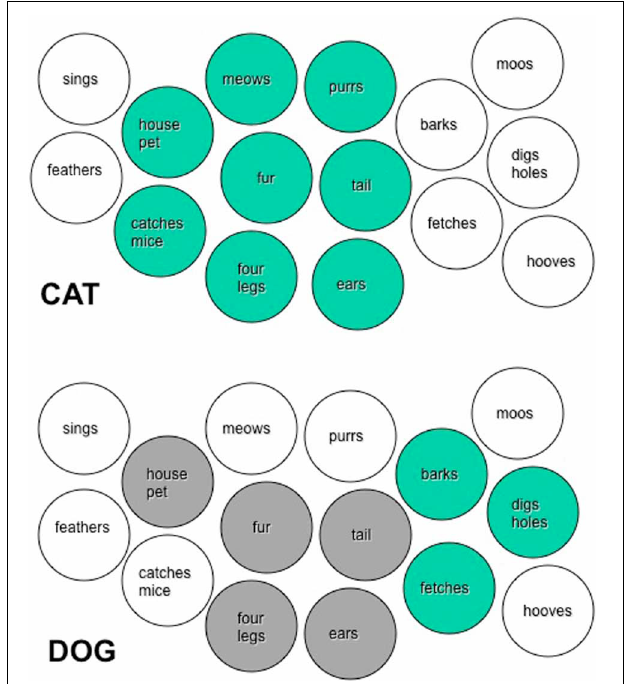
FIGURE 1 | Schematic depicting the activation of some of the semantic features that would represent the words CAT and DOG, in the distributed system of the RH, during a hypothetical experimental trial, where these words are presented as S1 and S2. In the top panel the circles with green fill correspond to the semantic features that would be activated by CAT. White circles are features of other concepts. In the bottom panel , all gray circles represent the features activated by the word DOG. Dark gray circles indicate those that are held in common with CAT, and were thus preactivated before the presentation of DOG. Green circles indicate features that are unique to